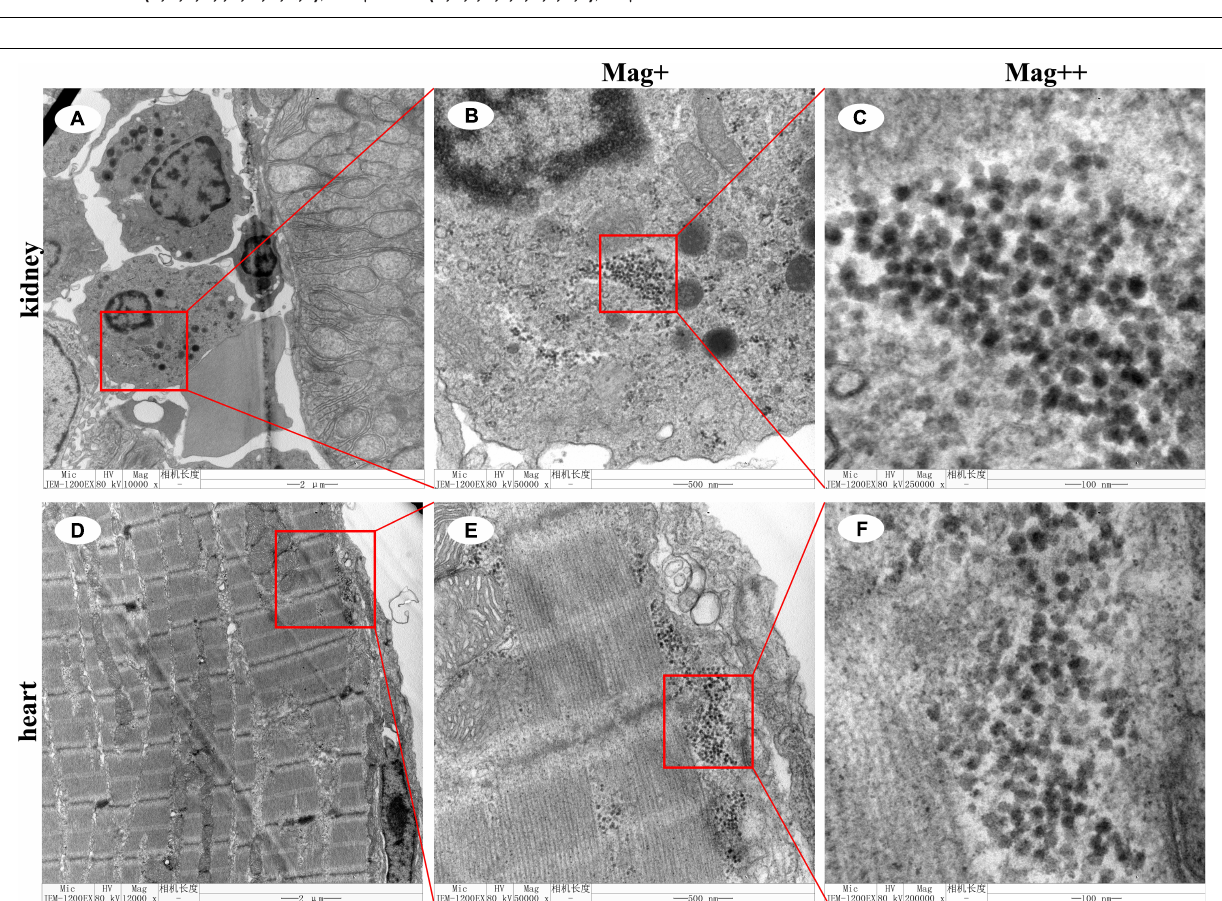
FIGURE 2 | moderate vacuolation (pointed by black arrows) and degenerated erythrocytes (pointed by white arrows) of the spleen. Intensive purple hybridization signals of CMNV probe could be observed at the spleen. (M) Micrographs of ISH for the eye. (N) Magnified micrograph of the zone in the black frame in (M) . (O) Micrographs of HE staining for the eye. (P) Magnified micrograph of the zone in the black frame in (O) . Note the serious vacuolation (pointed by black arrows) at the bipolar cells layer. Intensive purple hybridization signals of the CMNV probe could be observed at the bipolar cells layer. (Q) Micrographs of ISH for gill. (R) Magnified micrograph of the zone in the black frame in (Q) . (S) Micrographs of HE staining for gill. (T) Magnified micrograph of the zone in the black frame in (S) . Note the disorganized secondary lamella (pointed by black arrows). Intensive purple hybridization signals of the CMNV probe could be observed at the secondary